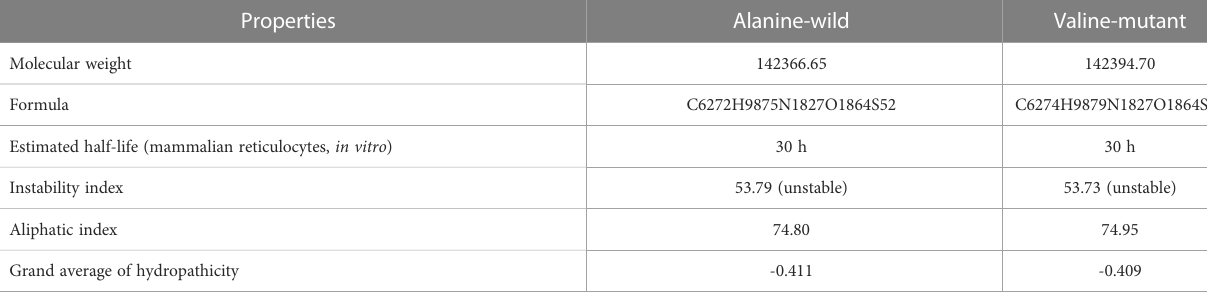
TABLE 1 Comparison of physiochemical properties of variant c.2060C>T; A687V.